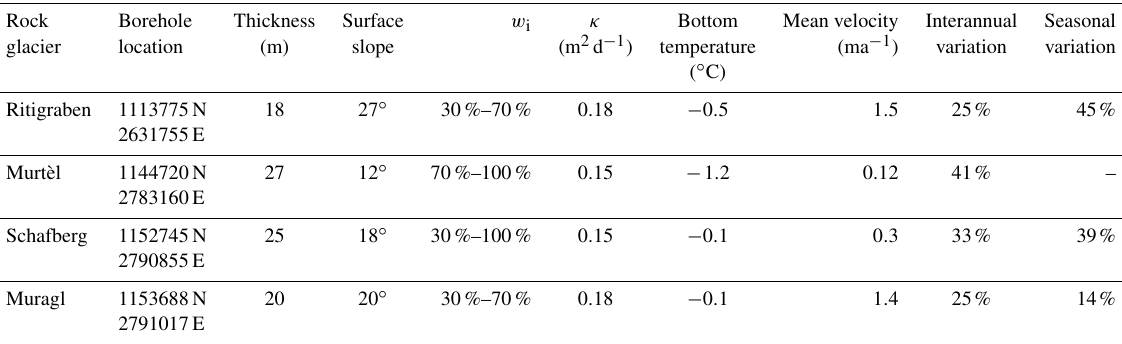
Table 1. Summary of field sites. The borehole locations are given in the CH1903+ coordinate system. The values of the geometrical and physical properties of the rock glaciers are given (thickness, slope, volumetric ice content and thermal diffusivity) as discussed in Sect. 2. For the ice content an acceptable range of values is proposed according to the literature (Hoelzle et al., 1998; Arenson et al., 2002). The mean observed rock glacier bottom temperature, measured at the lower end of the shear horizon (from summer 2006 to summer 2015) and surface velocity (from summer 2009) are reported, as well as the interannual and seasonal velocity variations relative to the mean velocity (from summer 2012 to summer 2016) (PERMOS,